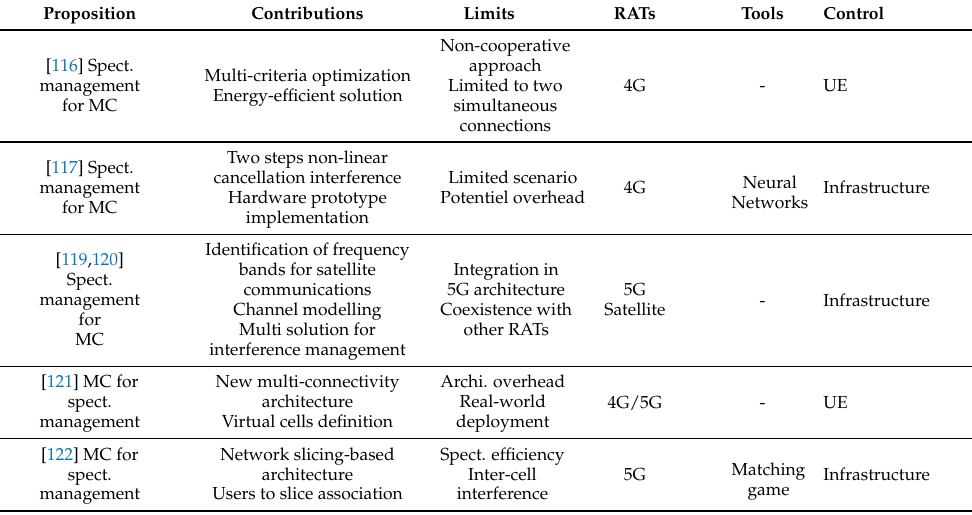
Table 7. Comparison of existing solutions for improving spectrum and interference